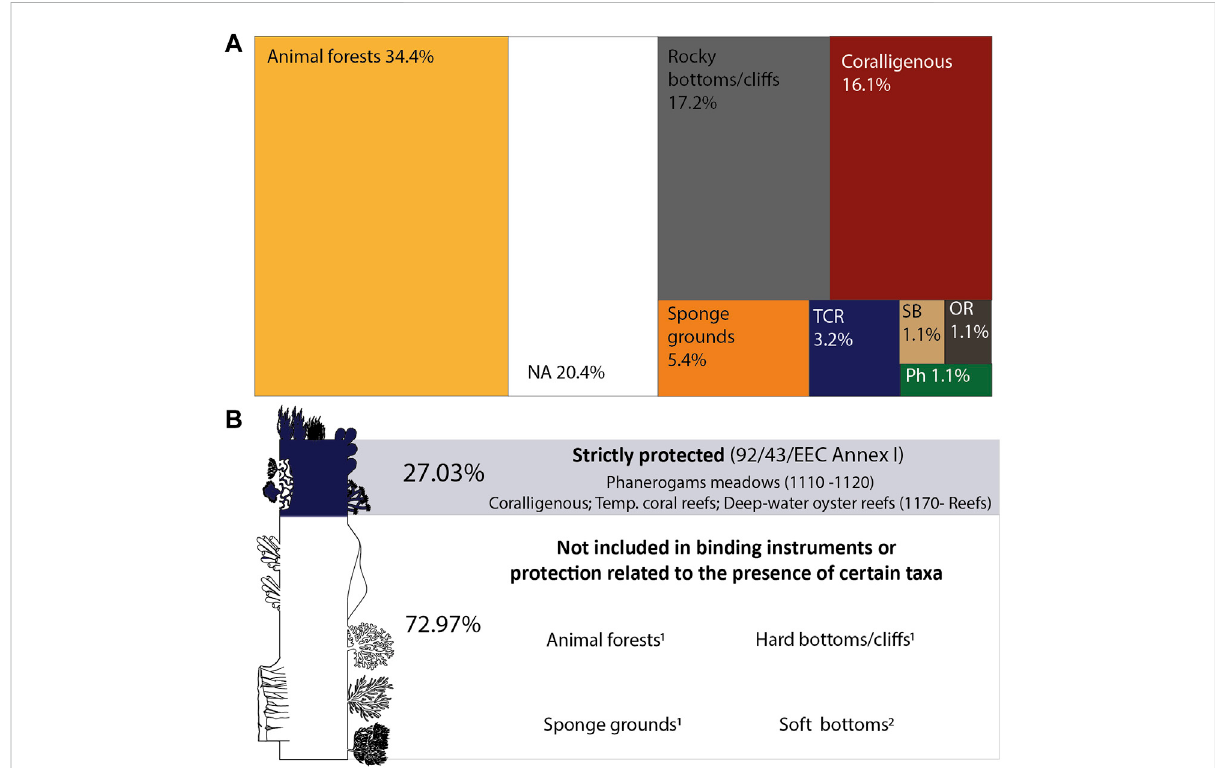
FIGURE 2 Proportionofmesophotichabitats studiedintheMediterraneanSea (A) andtheproportion ofrecordstargetinghabitats included inthecurrent InternationalPolicyFramework (B) . 1 Habitats de fi ned as VMEinFAO, 2009. 2 Only soft-bottom habitats (1110-Sandbanks)shallower than 20 m depth are listed under the Habitats Directive (Romão, 1996). TCR: temperate coral reefs; SB: soft bottom; OR: deep-water oyster reef; Ph: Phanerogam meadows; NA: not available.